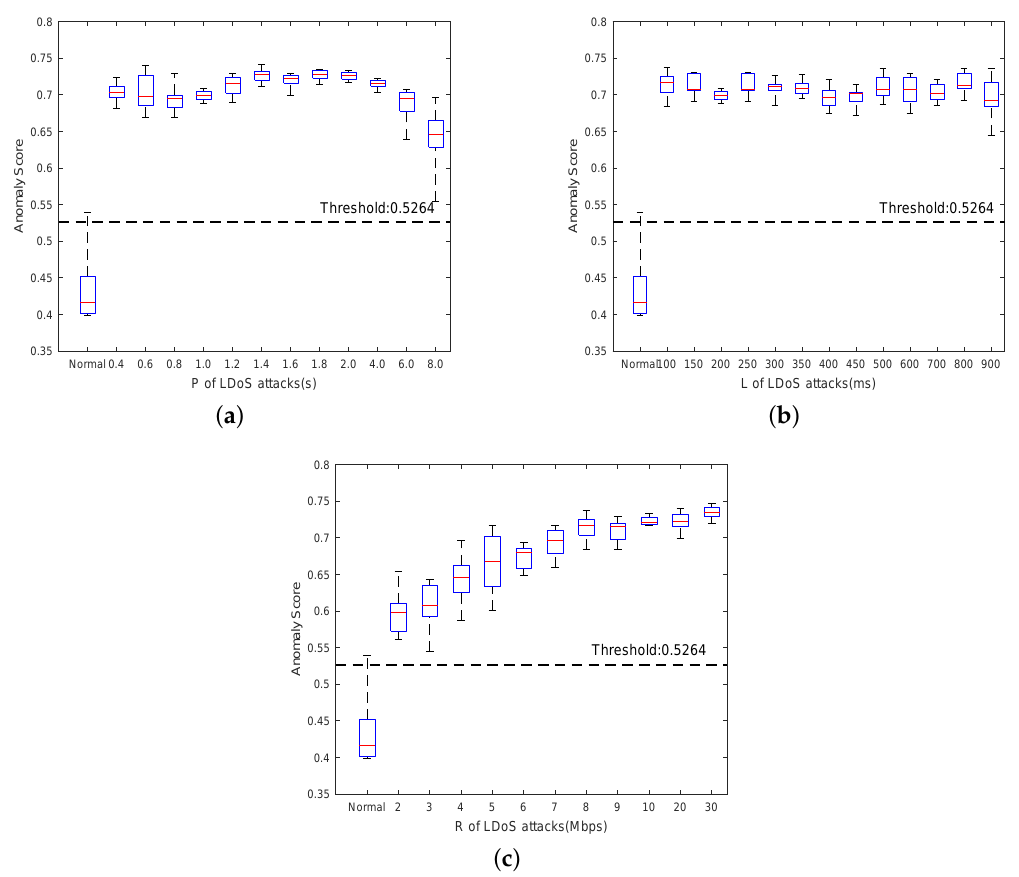
Figure 11. Anomaly score between normal state and LDoS attacks of different parameters: ( a ) shows LDoS attack of R = 8 Mbps, P = [0.4,8] s, L = 0.2 s compare with the normal state, ( b ) depicts LDoS attacks of R = 8 Mbps, P = 1 s, L = [0.1,0.9] s compare with the normal state, and ( c ) presents LDoS attacks of R = [2,30] Mbps, P = 1 s, L = 0.1 s compare with the normal state.The boxes include maximum value, 75th percentile, median value, 25th percentile, and minimum value of anomaly score under different LDoS attacks. The red lines in all the boxes are the median